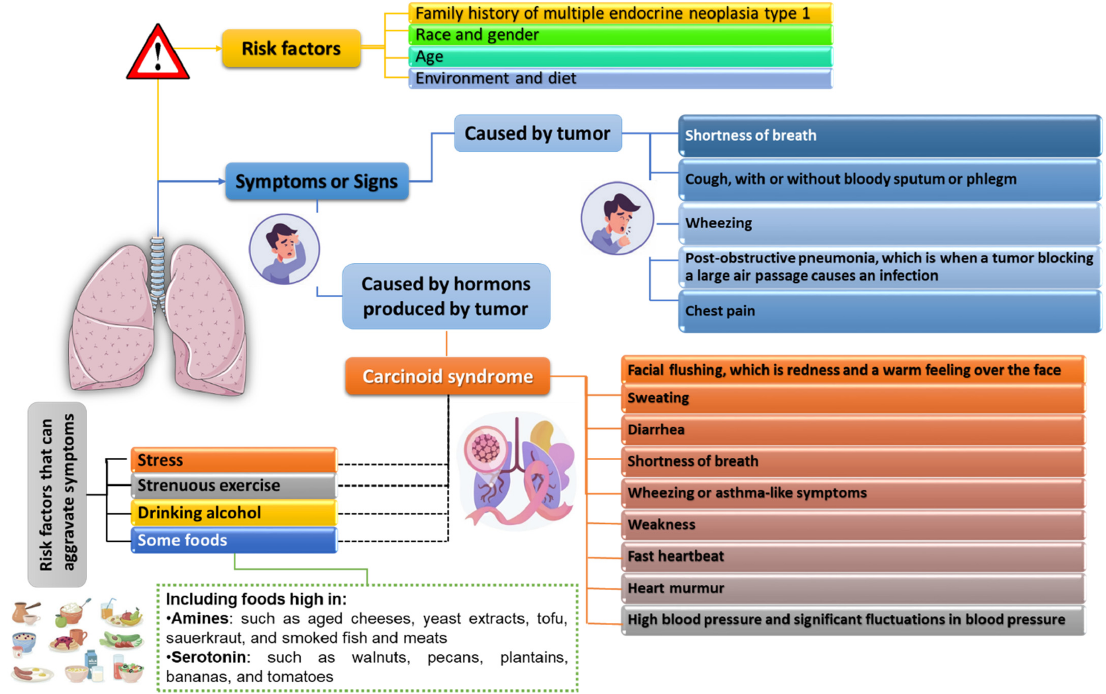
Figure 3. Risk factors, symptoms and signs of lung neuroendocrine tumors development based on [52,53].